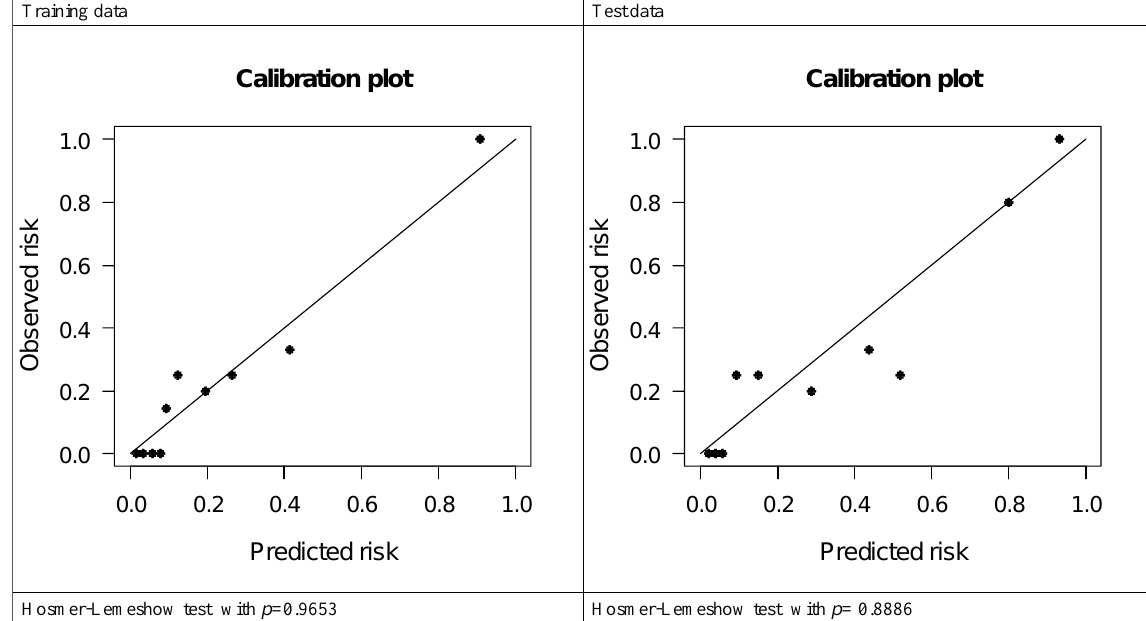
Figure 2. ROC analysis for predicting LECS requirement during endoscopic resection.